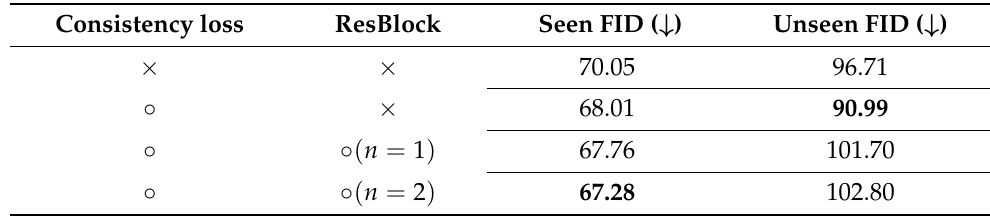
Table 4. Effect of consistency loss and ResBlock on FID. n represents the number of ResBlock. Bold values indicate the best performance.